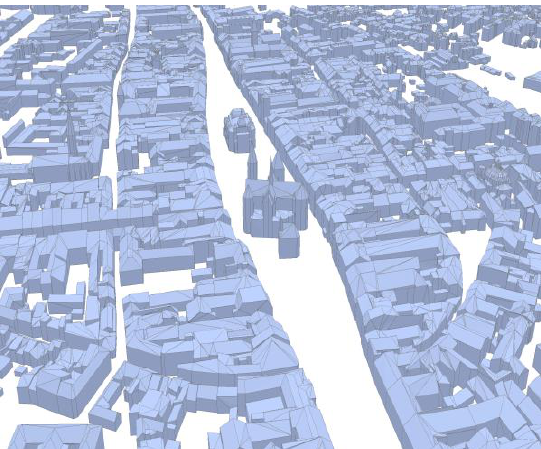
Figure 2 . 3D city model of